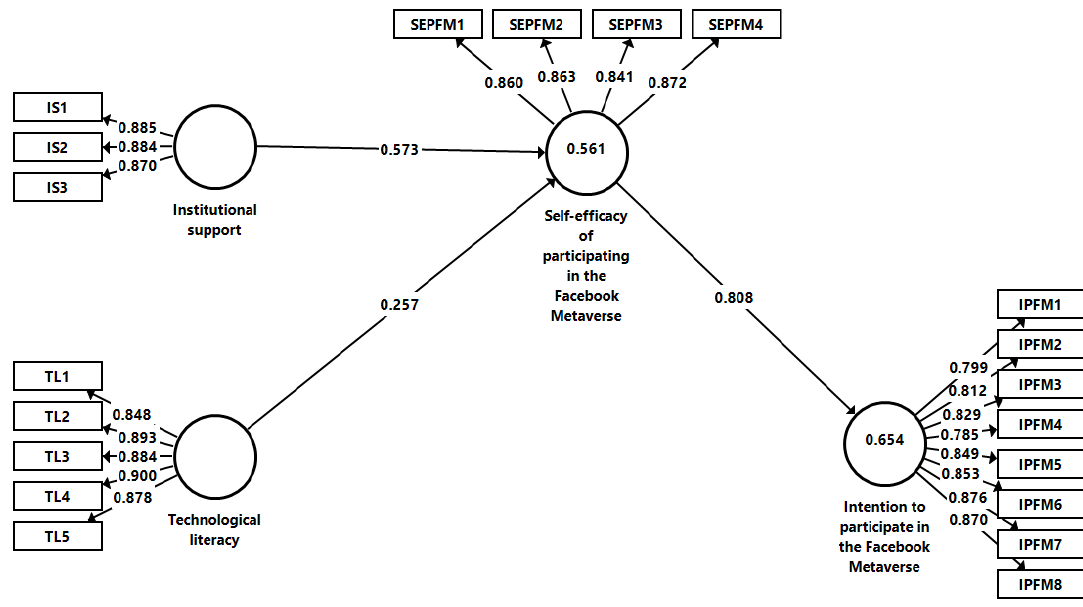
Figure 2. Research model evaluated.